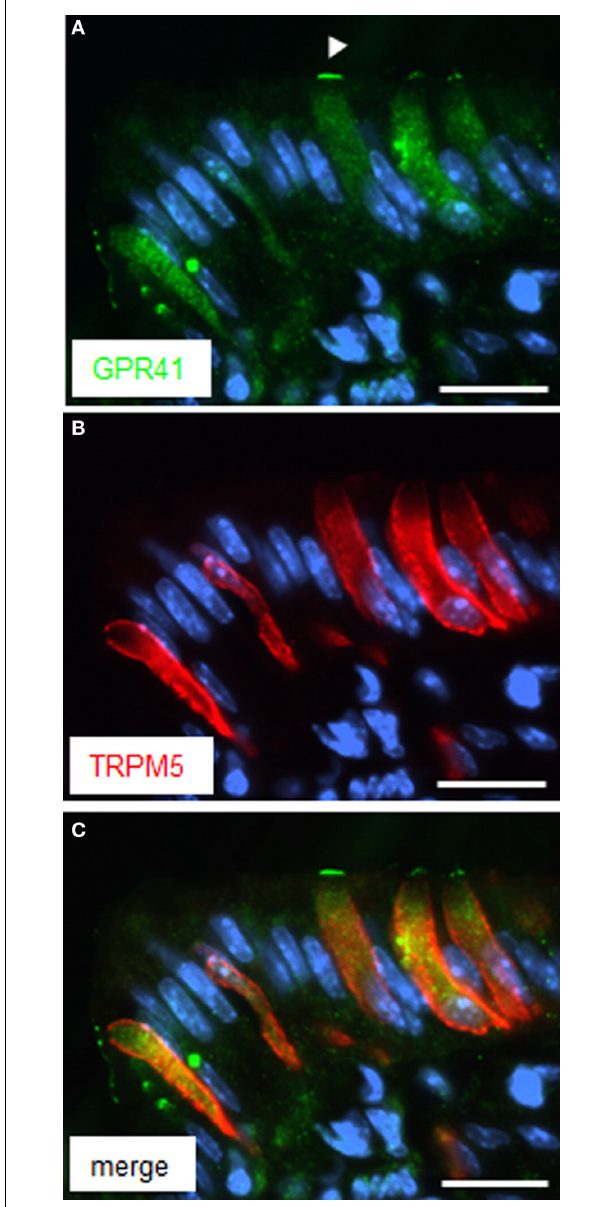
FIGURE 5 | GPR43 is expressed in TRPM5 positive cells at the “gastric groove.” (A) RT-PCR approaches analyzing normalized cDNA of gastric tissue from fundus and the fundus/corpus boundary, respectively, were conducted with primer pairs specific for GPR43 (465bp); for cDNA of the fundus/corpus transition zone a transcript of the expected size was obtained. Water control without template showed no amplicon. (B,C) Double-immunolabeling employing antibodies against GPR43 (green) and TRPM5 (red) on corpus tissue sections. The GPR43-antibody labeled numerous cells (B) . Co-staining with the TRPM5-antibody (C) revealed an overlap of both immunostainings (D) . Sections were counterstained with DAPI ( blue ). Scale bars : (B–D) = 20 μ